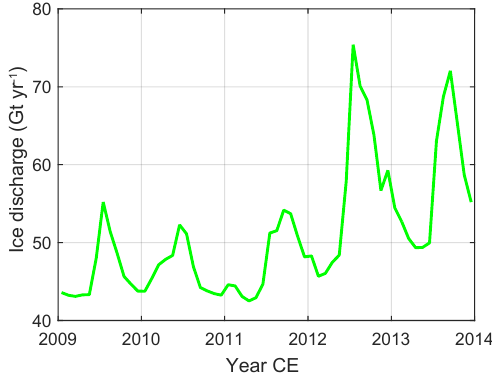
Figure 10. Monthly variations of ice discharge of Jakobshavn Glacier over the period 2009–2013 (Gtyr − 1